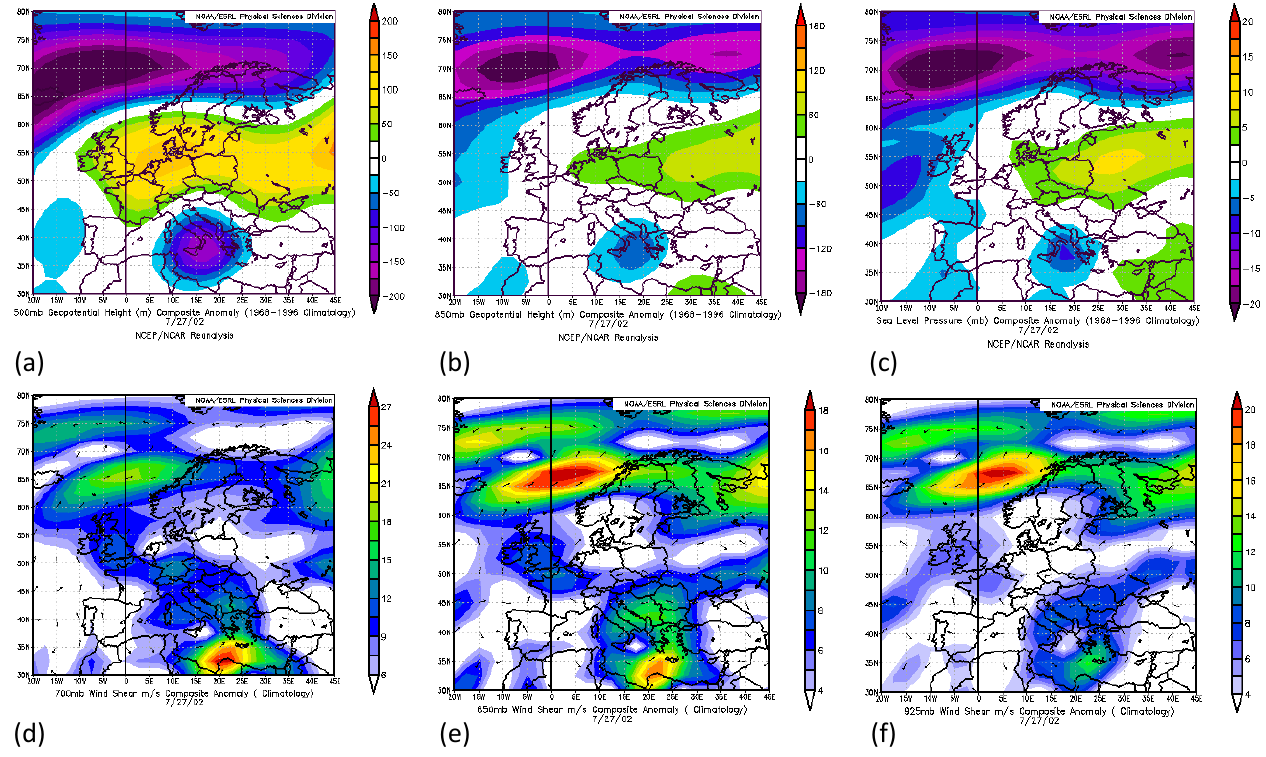
Figure 3. Daily composite anomaly (reference period: 1968-1996) of geopotential heights at the isobaric levels of 500 hPa (a) and 850 hPa (b), of sea-level pressure (c) and daily composite anomaly (reference period: 1968-1996) of wind shear at 700 hPa (d), 850 hPa (e) and 925 hPa (f), on July, 27 2002, from NCEP / NCAR reanalysis datasets.